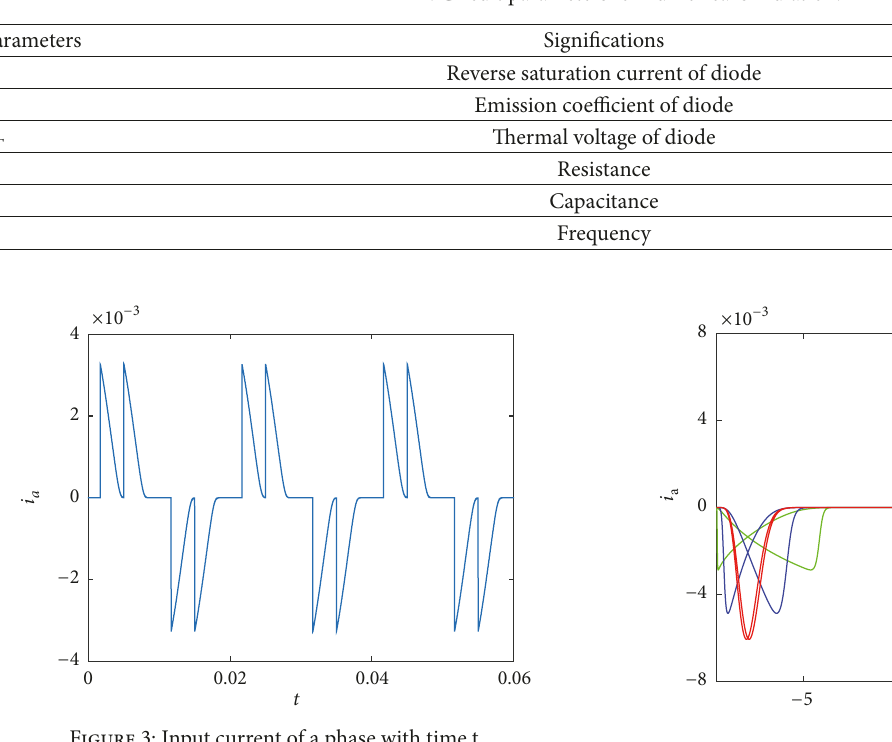
Table 2: Circuit parameters for numerical simulation.